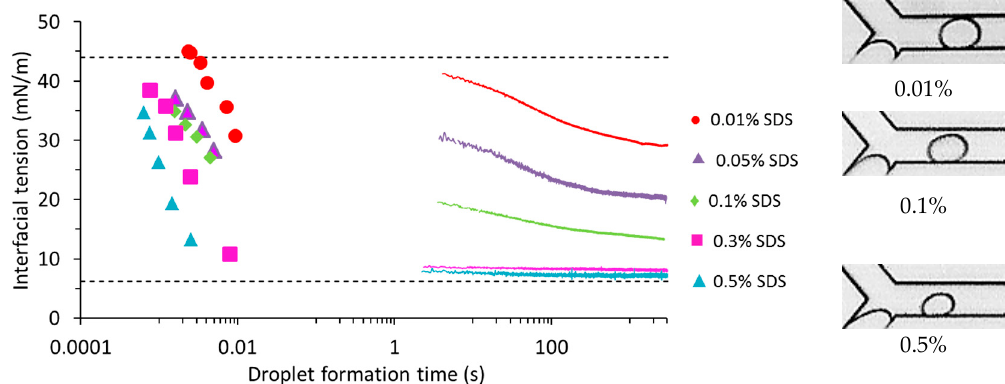
Figure 11. Interfacial tension at the hexadecane-water interface with various sodium dodecylsulfate (SDS) concentrations in the aqueous phase, as measured with a microfluidic Y-junction (symbols) and with a droplet volume tensiometer (solid lines). The dotted lines represent the equilibrium interfacial tensions between hexadecane and water (top) and between hexadecane and a 1% wt. SDS solution (bottom). On the right images of droplets made for the indicated concentrations at a droplet formation time of 1.5 millisecond (channel width = 18 µm, channel depth = 5 µm). Adapted from Muijlwijk et al. [73], with permission from Elsevier.